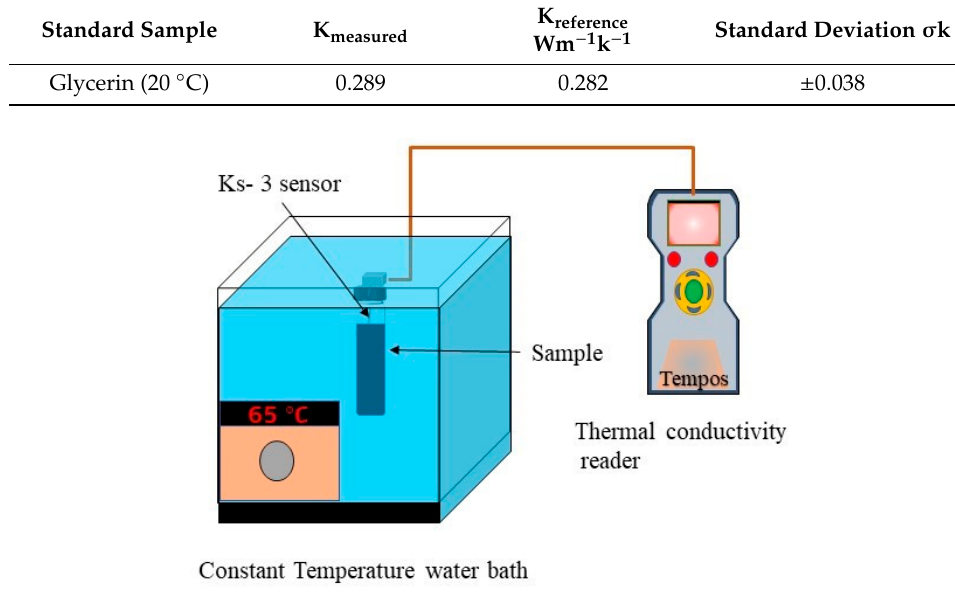
Table 2. Calibration details of Tempos thermal conductivity analyzer.